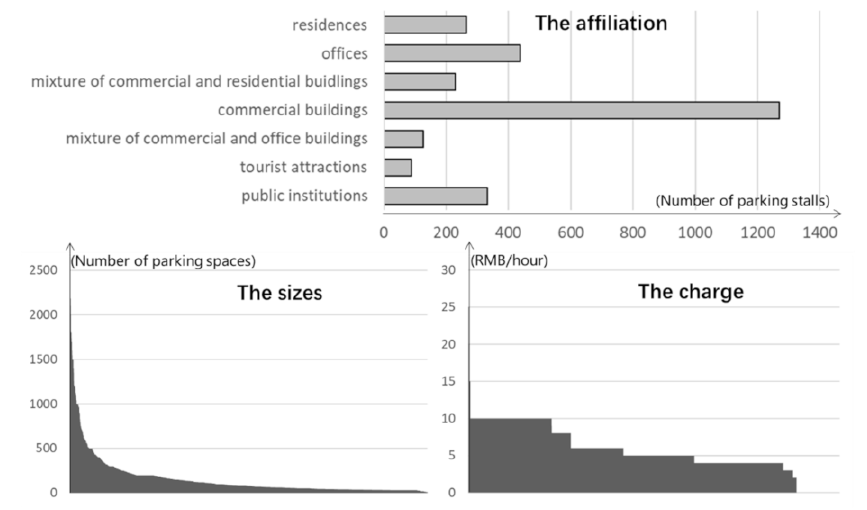
Figure 6. Characteristics of the parking lots in Hangzhou.